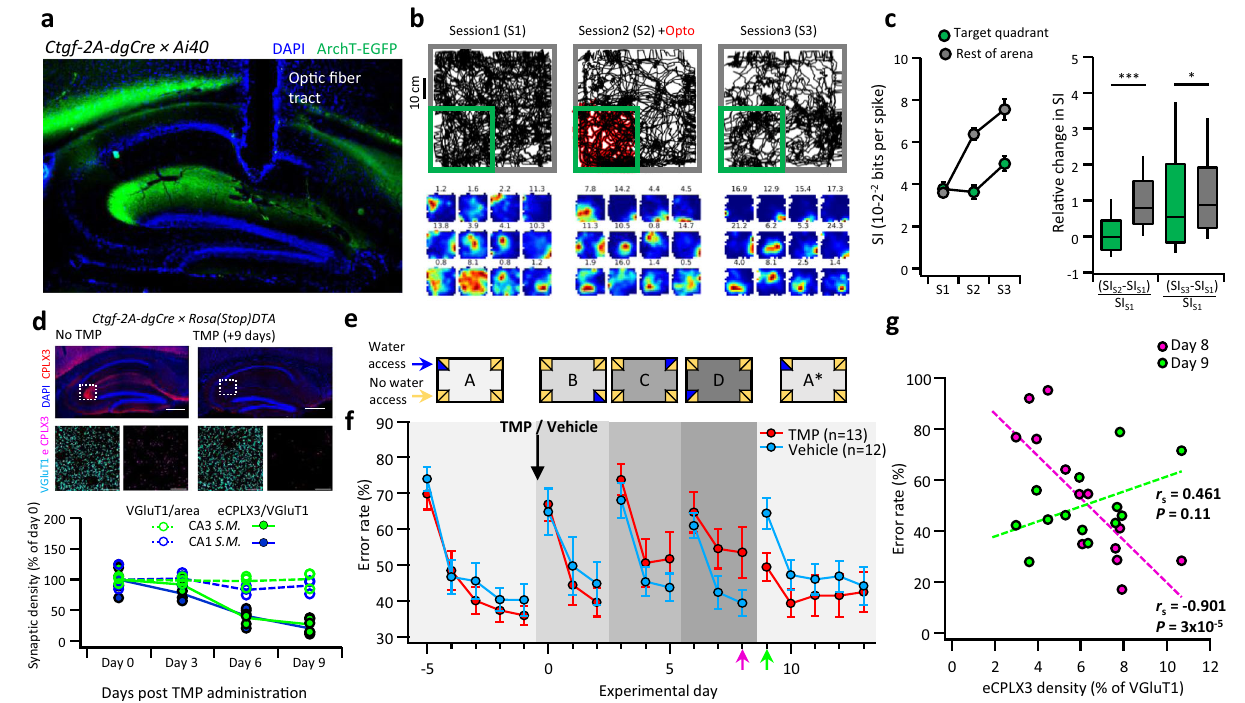
Fig. 5 | Inhibition of EC-6b neurons affects spatial information processing and memory formation. a Representative parasagittal section showing speci fi c expressionofArchT-EGFPinlayer6bandthelocationoftheoptic fi berinaCtgf-2A- dgCre crossed with an ArchT-EGFP (Ai40) cre reporter mouse. b Representative positionplotsforthethreeconsecutiveexposuresessions(top)andcorresponding fi ring-ratemapsof12representativeunits,rankedbytheirspatialinformationscore in S3. Numbers above each plot note the peak fi ring rate (Hz). c A summary plot showing the average spatial information for CA1 pyramidal cells within the illumi- nated quadrant (green) relative to the rest of the arena (gray) in each exposure session (left) alongside a box plot showing the median change in SI between S2-S1 and S3-S1 for cells inside and outside of the target region (right). Boxplot center, bounds of box and whiskers represent the median, top and bottom 25th and top and bottom 10th percentile, respectively. A total of 184 units from 4 animals were included in the analysis. Single (*) and triple asterisks (***) indicate P <0.05 and P <0.001, respectively. d Representative images of the hippocampus of a Ctgf-2A- dgCre crossed with a Rosa(stop)DTA mice, immunolabeled for CPLX3, either